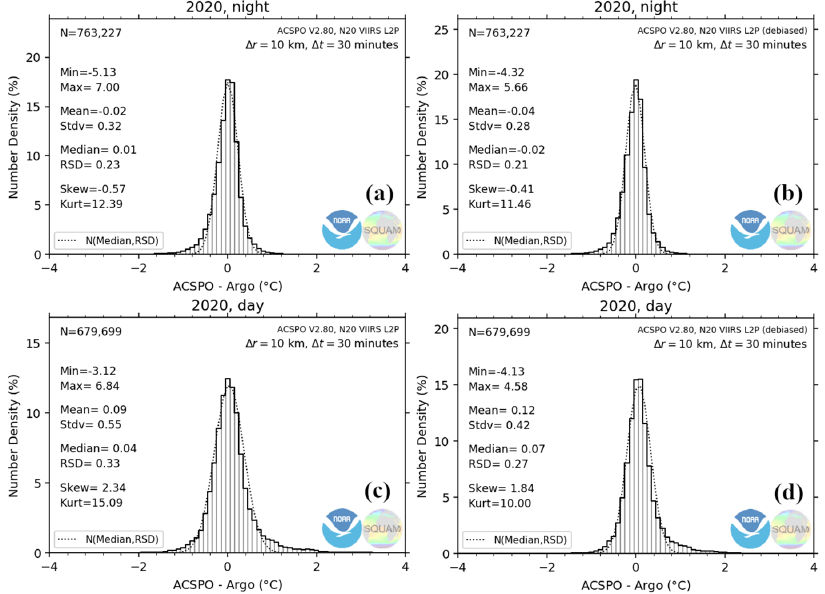
Figure 10. Panels ( a – d ) show the same results as Figure 6 but against the AFs.